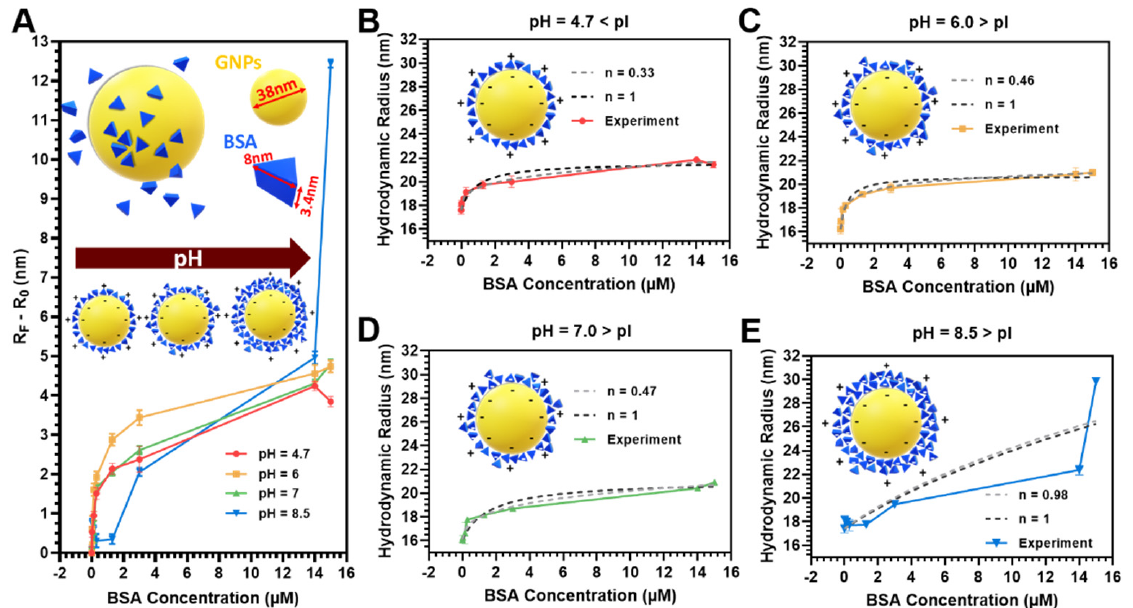
Figure 2. Adsorption isotherms (T = 25 °C) showing hydrodynamic radii experimentally determined with dynamic light scattering as a function of BSA concentration and pH. ( A ) Adsorption of BSA on the GNP surface at different pH values above and below the isoelectric point (pI) of BSA (pI = 5, Ge et al. [67]). The y-axis in ( A ) was calculated by subtracting the hydrodynamic radii of the citrate-GNPs (R0) at their respective pH from the hydrodynamic radius of each adsorption point experimentally determined (RF). Data are fit using the Langmuir model following the approach of Dominguez-Medina et al. [61] and the results are reported for ( B ) pH = 4.7, ( C ) pH = 6.0, ( D ) pH = 7.0, and ( E ) pH = 8.5. Isotherms with returned best fit Hill coefficient where n is variable (gray dashed line) or non-cooperative binding model where n = 1 (dashed black line). The adsorption isotherms for 35 nm GNPs at pH 4.7, 6.0, and 7.0 follow an anti-cooperative binding model, while at pH 8.5 they follow a cooperative binding model.